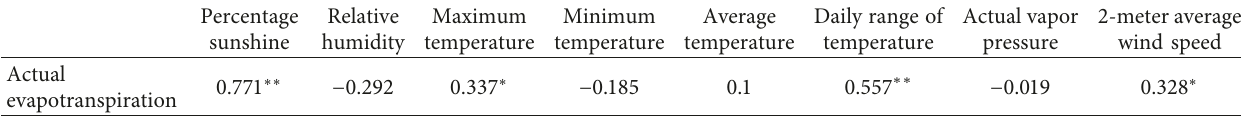
Table 3: Correlation coefficients between meteorological factors and actual evapotranspiration.